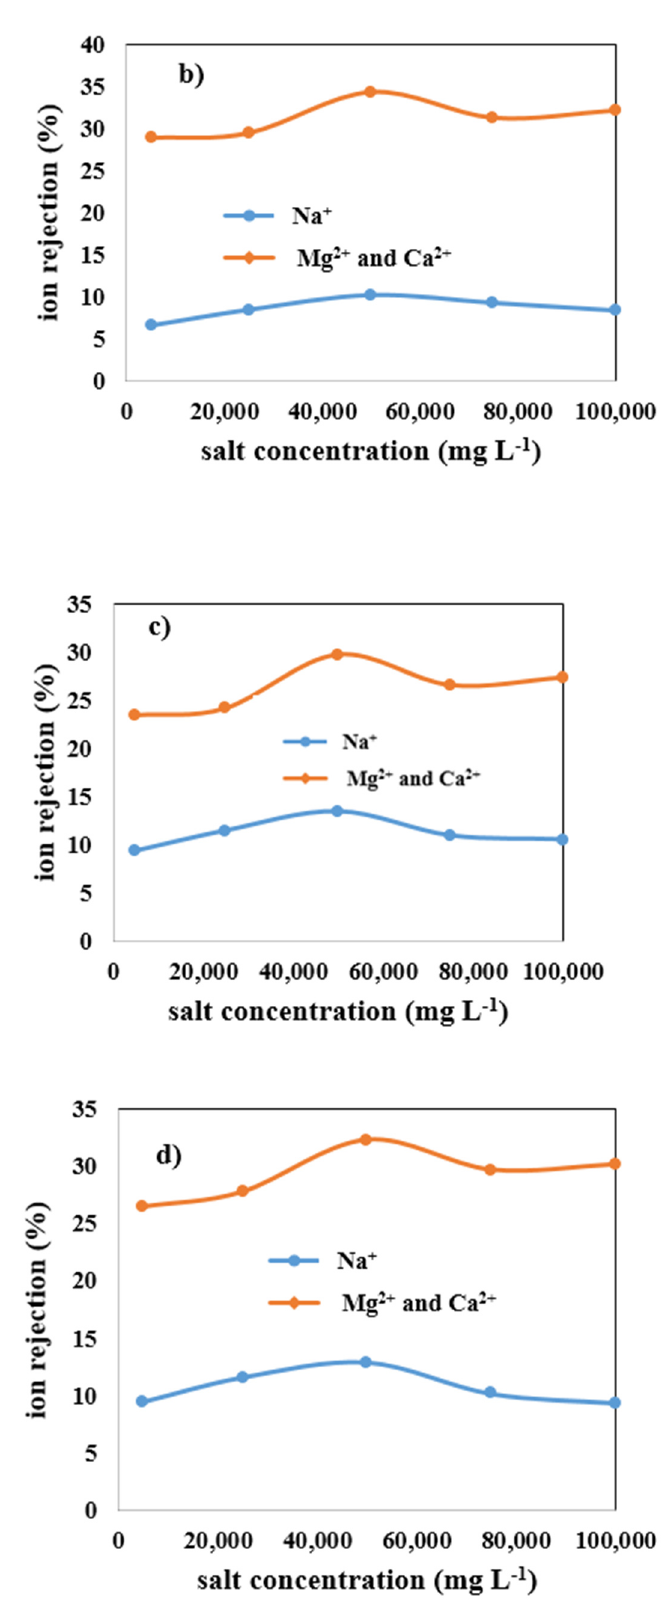
Figure 11. Effect of increasing salt concentration in wastewater on monovalent (Na + ) and multivalent (Mg 2+ and Ca 2 +) ions rejection of membranes, ( a ) mullite, ( b ) mullite-alumina, ( c ) mullite-alumina-zeolite, ( d ) mullite-zeolite.